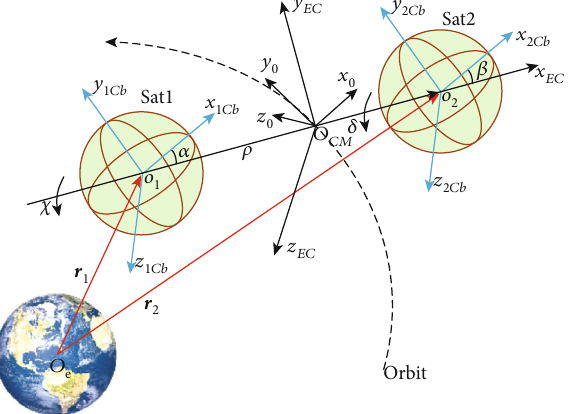
Figure 1: Coordinate systems and their